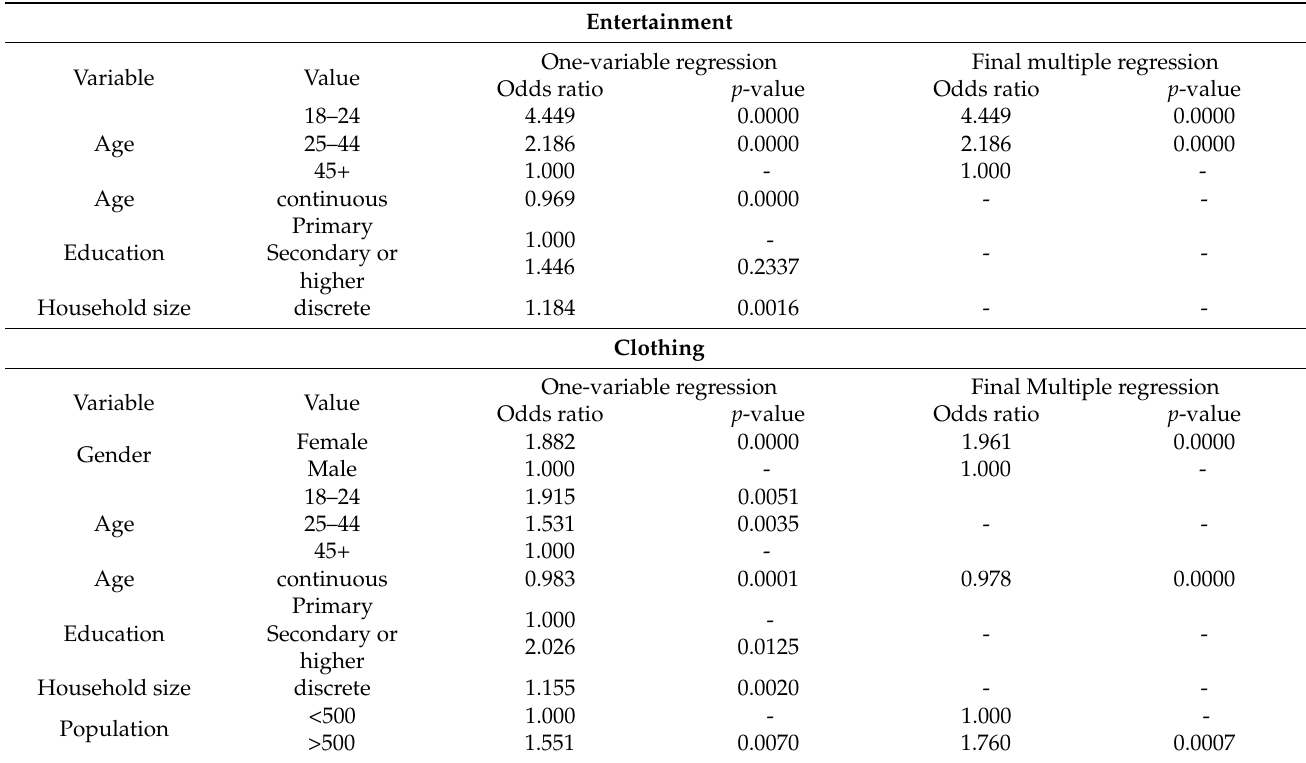
Table A1. Logistic regression for “increase” for groups of products purchased online (own